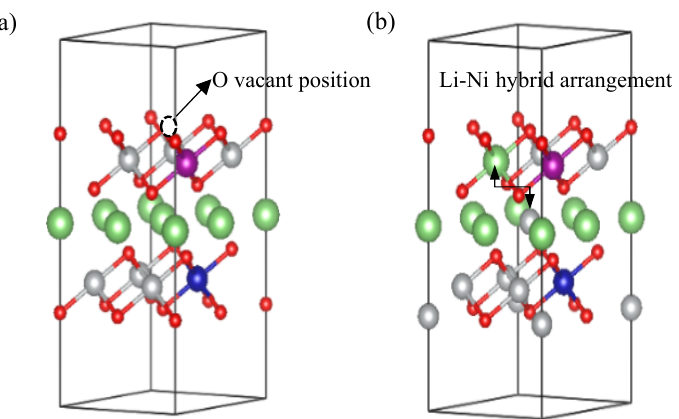
Figure 9. Schematic diagram of two typical defects ( a ) oxygen vacancy (V O ), ( b ) lithium nickel mixed arrangement (Li Ni –Ni Li ).